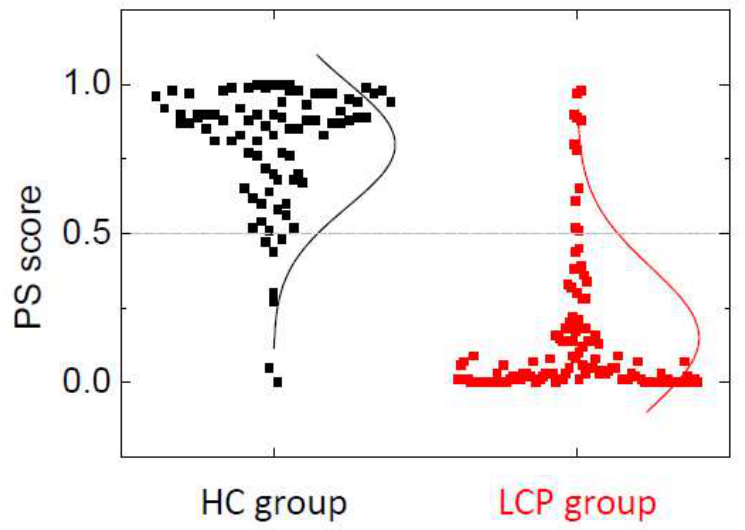
Figure 3. Distribution of the probability score (PS) score within healthy individuals (HC group) and lung cancer patients (LCP group). The lines represent an equivalent Gaussian distribution. The PS score threshold for discriminating between an unaltered (associated with healthy status) and altered (associated with lung cancer status) serum proteome thermal liquid biopsy (TLB) thermogram is 0.5 (grey dotted line). It can be observed that seven healthy subjects are assigned a PS score lower than 0.5 (8% false positive rate) and 11 lung cancer subjects are assigned a PS score higher than 0.5 (10% false positive rate).